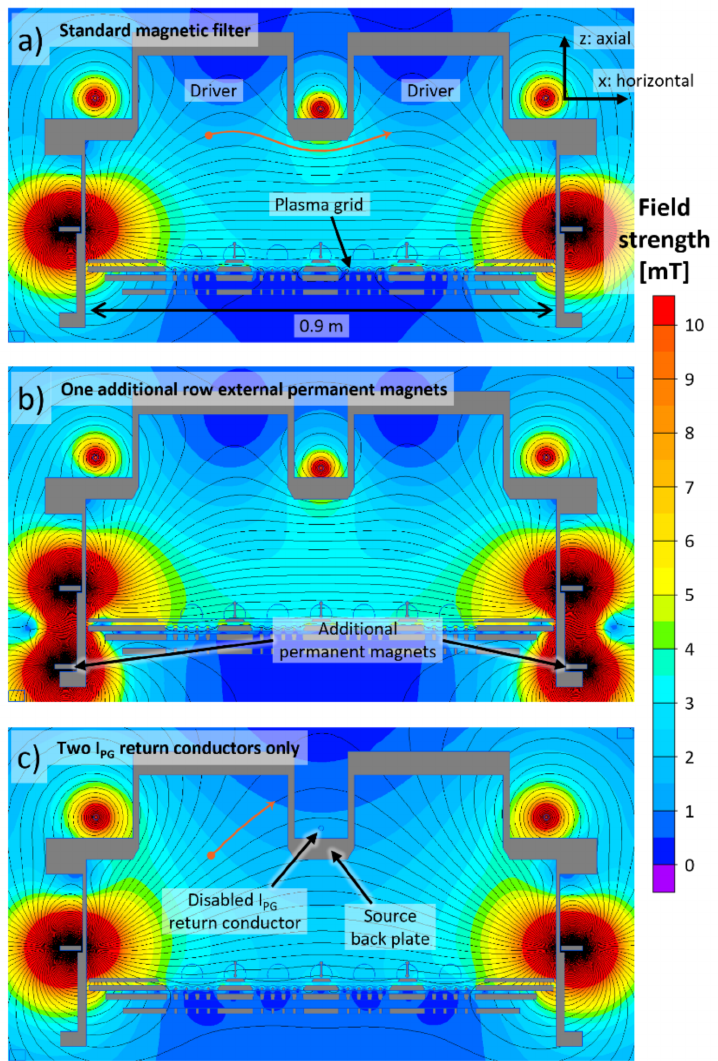
Figure 2. 2D structure (horizontal/axial cross section) of the field strength for three different topolo- gies of the ELISE magnetic filter. ( a ) the standard filter, ( b ) one additional row of external permanent magnets and ( c ) only two IPG return conductors. The orange lines illustrate the strong effect of disconnecting the central IPG return conductor on the field topology in and close to the RF drivers. Located in 7 mm axial distance to the PG is the bias plate with window-frame-like openings around the beamlet groups (see Figure 1), divided into two horizontal